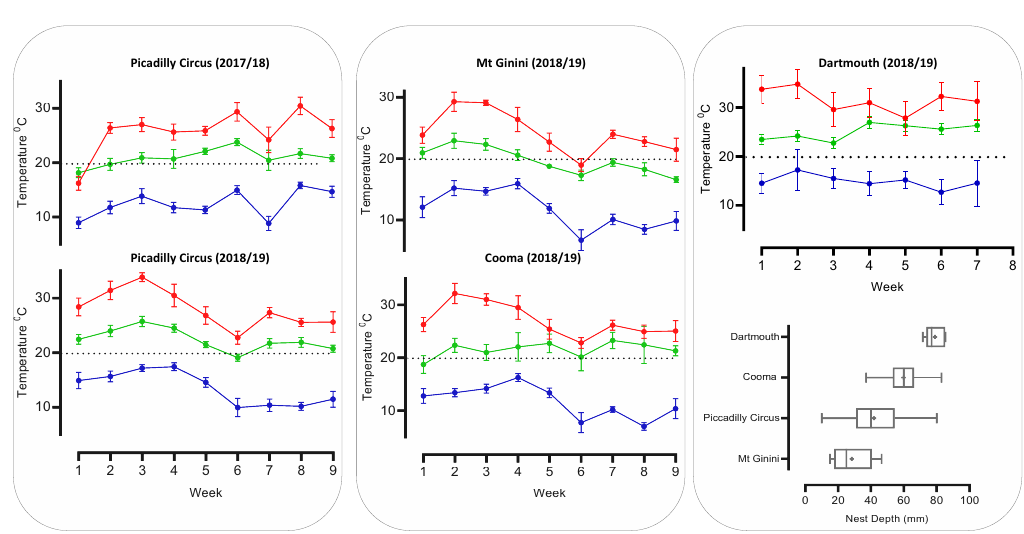
Figure 4. Weekly mean temperatures in the core of Bassiana duperreyi nests in each field locations (green) and the mean nest depth in each field location (right bottom). Red denotes Tmax and blue denotes